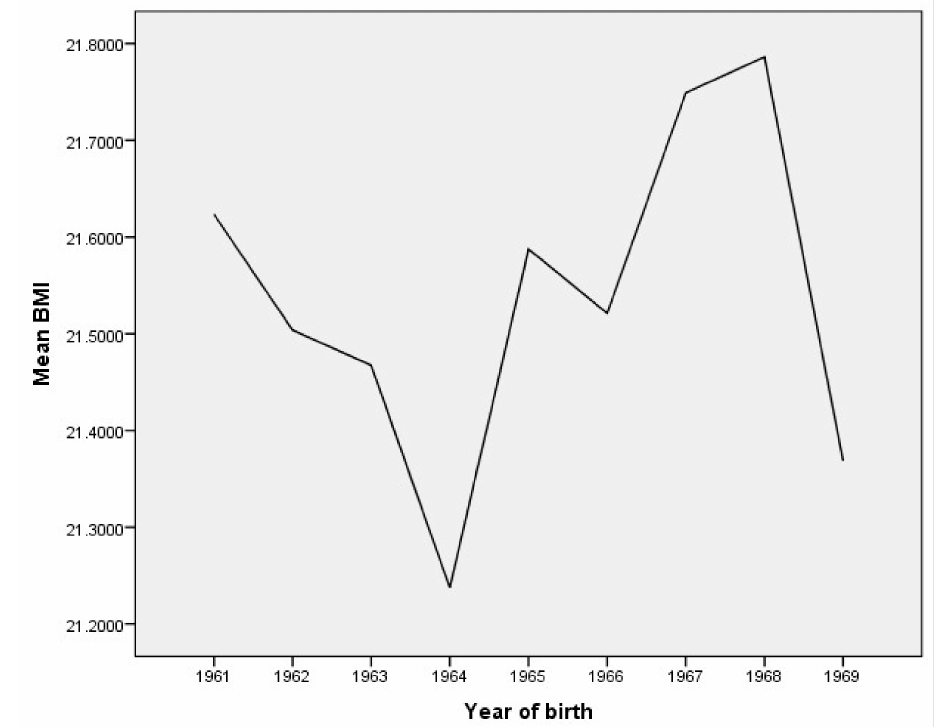
Figure 3. The mean body mass index (BMI) trends by year of birth in young males. Analysis of the differences in body height, body weight, and body mass index of all young male inhabitants of the Municipality of Berane is shown in Tables 2–4. LSD post hoc testing with ANOVA shows that statistically significant differences among examined groups were